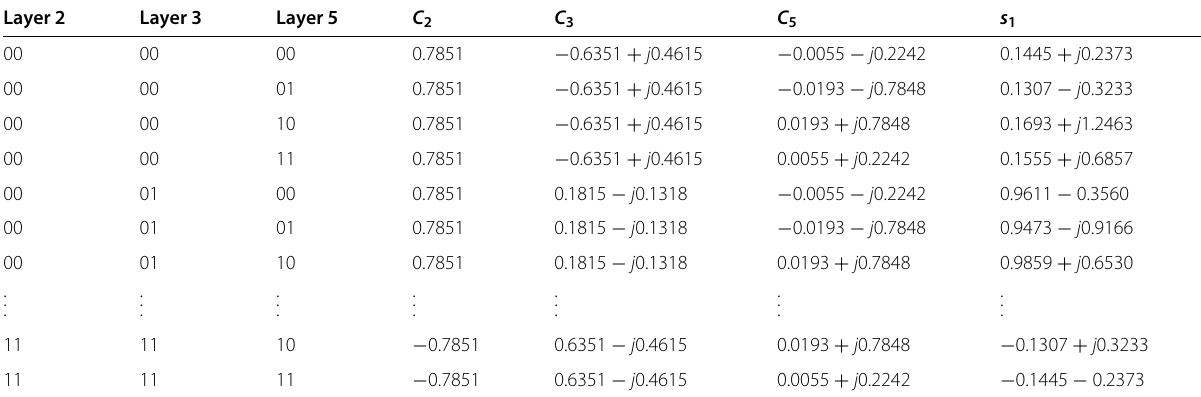
Table 3 Examples of the LUT for alphabet S 1